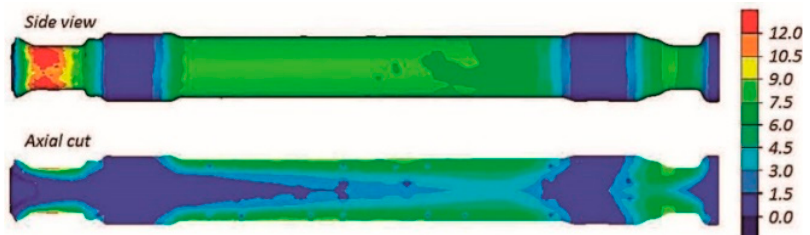
Figure 16. Distribution of strain intensity in the three-roll skew rolling rail axle [16] (Reprinted from ref. [16]).